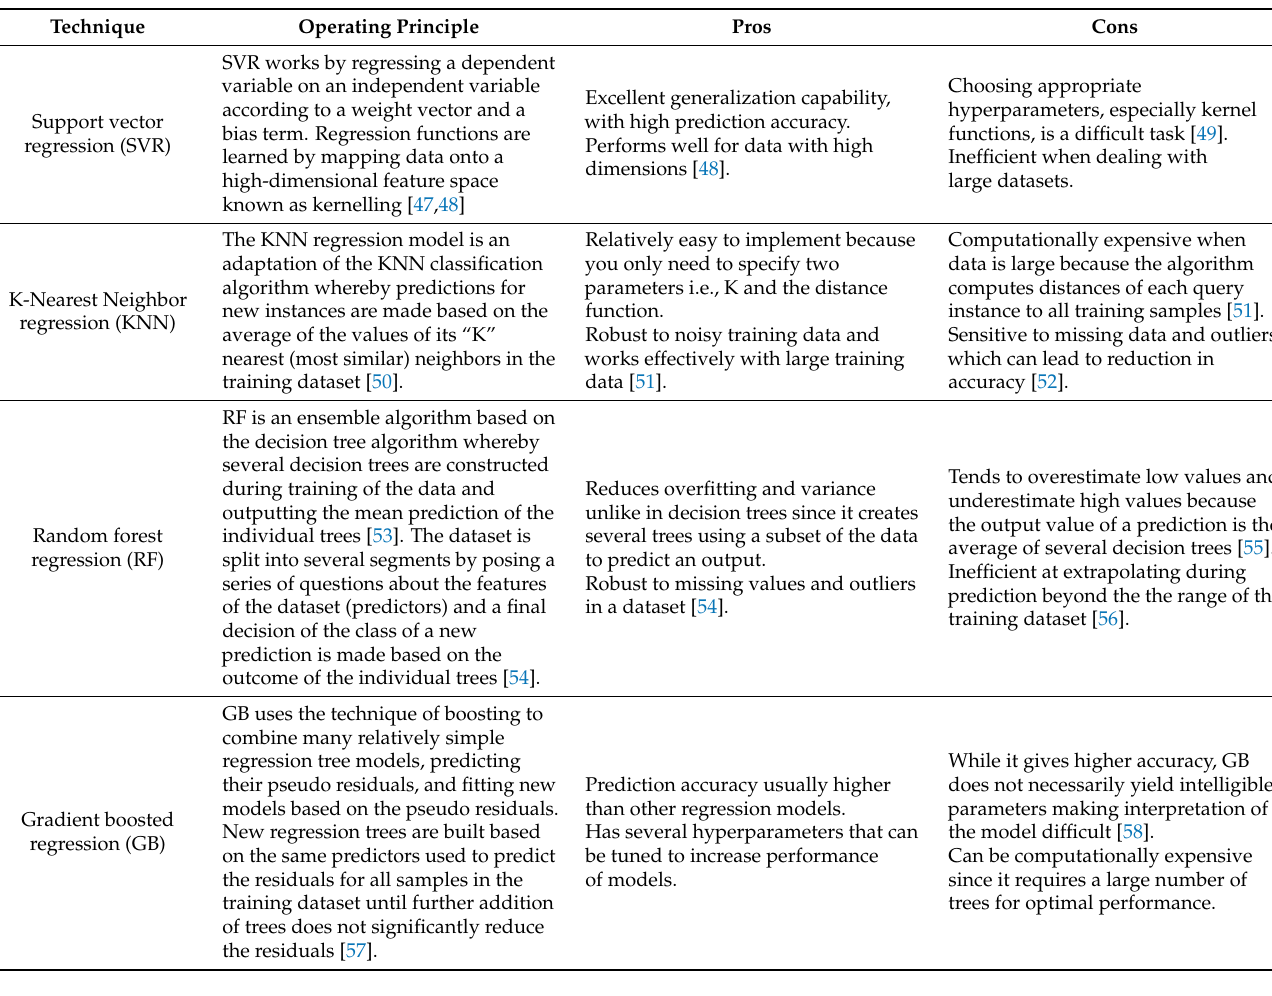
Table 2. Summary of machine learning techniques used for predicting CO 2 fluxes in this